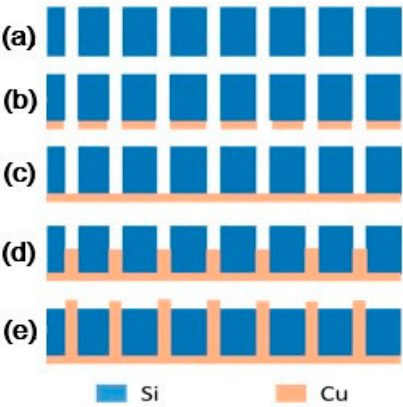
Figure 4. The electroplated copper growth process. ( a ) TSVs were etched and the SiO 2 insulation layer was deposited. ( b ) The adhesion layer (Cr, 30 nm) and seed layer (Cu, 300 nm) were sputtered. ( c ) Electroplated copper covered the TSVs. ( d ) Electroplated copper was grown in TSVs. ( e ) The TSVs were fully filled.